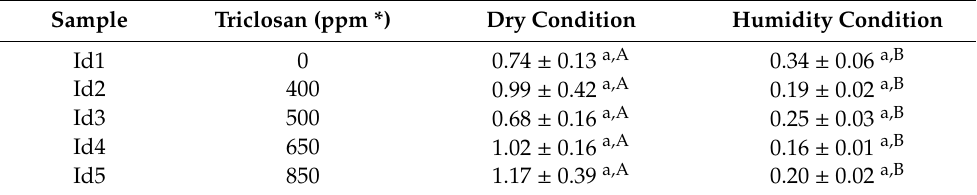
Table 1. Bacteriostatic activity (reduction values depicted in log 10 CFU / cm 2 ) of polyester surfaces in S. aureus treated with triclosan (400 ppm to 850 ppm) and tested under dry and humid conditions.